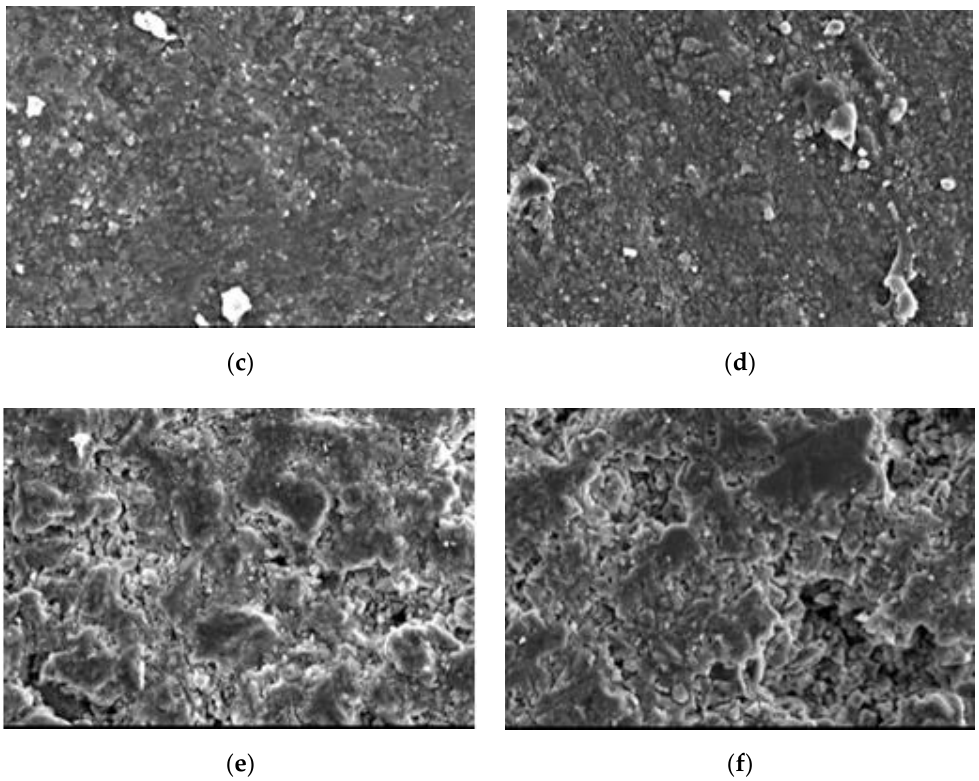
Figure 12. Typical SEM (1000 times) morphology images of cement paste at 28 days: ( a ) 20–50,000; ( b ) 40–90,000; ( c ) 70–0; ( d ) 70–2000; ( e ) 70–7000; and ( f ) 70–180,000 ppm.